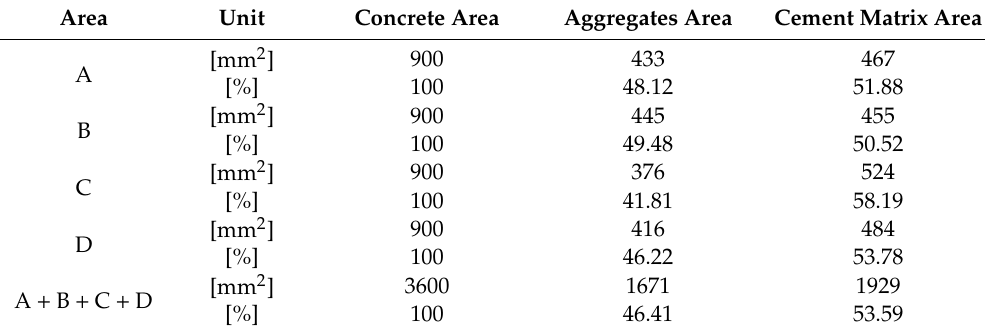
Table 2. Sample presented in Figure 5—aggregate and cement matrix areas and ratios. Area